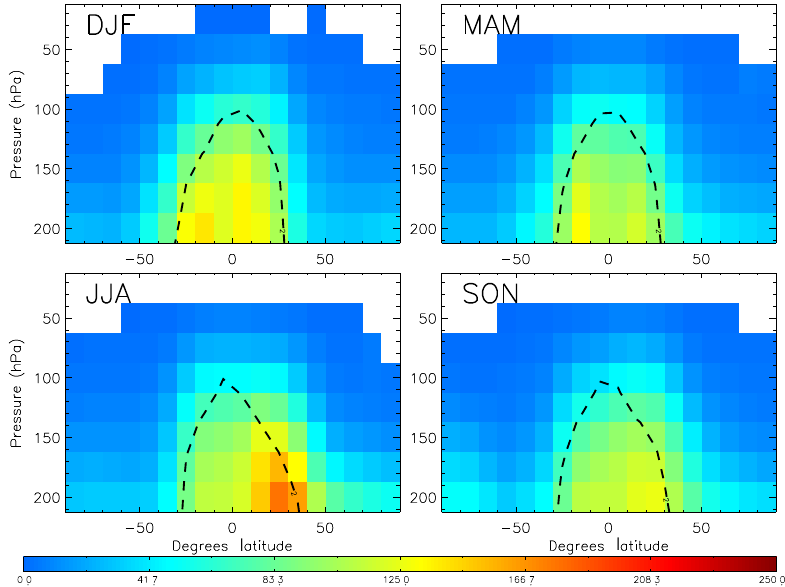
Figure 14. Zonal mean PAN (pptv) from the TOMCAT model (with IMK AKs applied) for 2007–2008 in DJF, MAM, JJA, and SON.